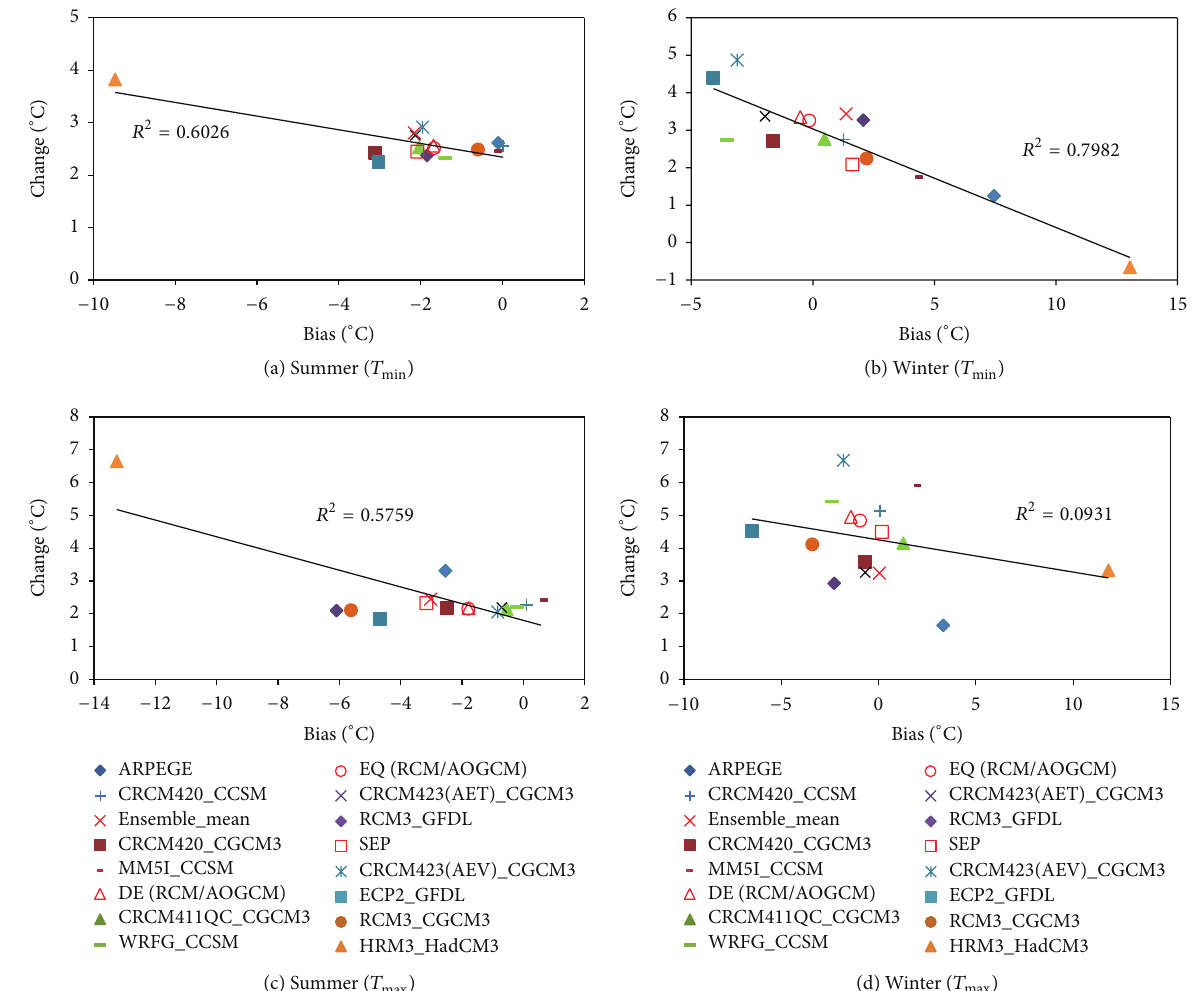
Figure 6: Same as Figure 4 but for the 90th percentile of 𝑇 min and 𝑇 max .